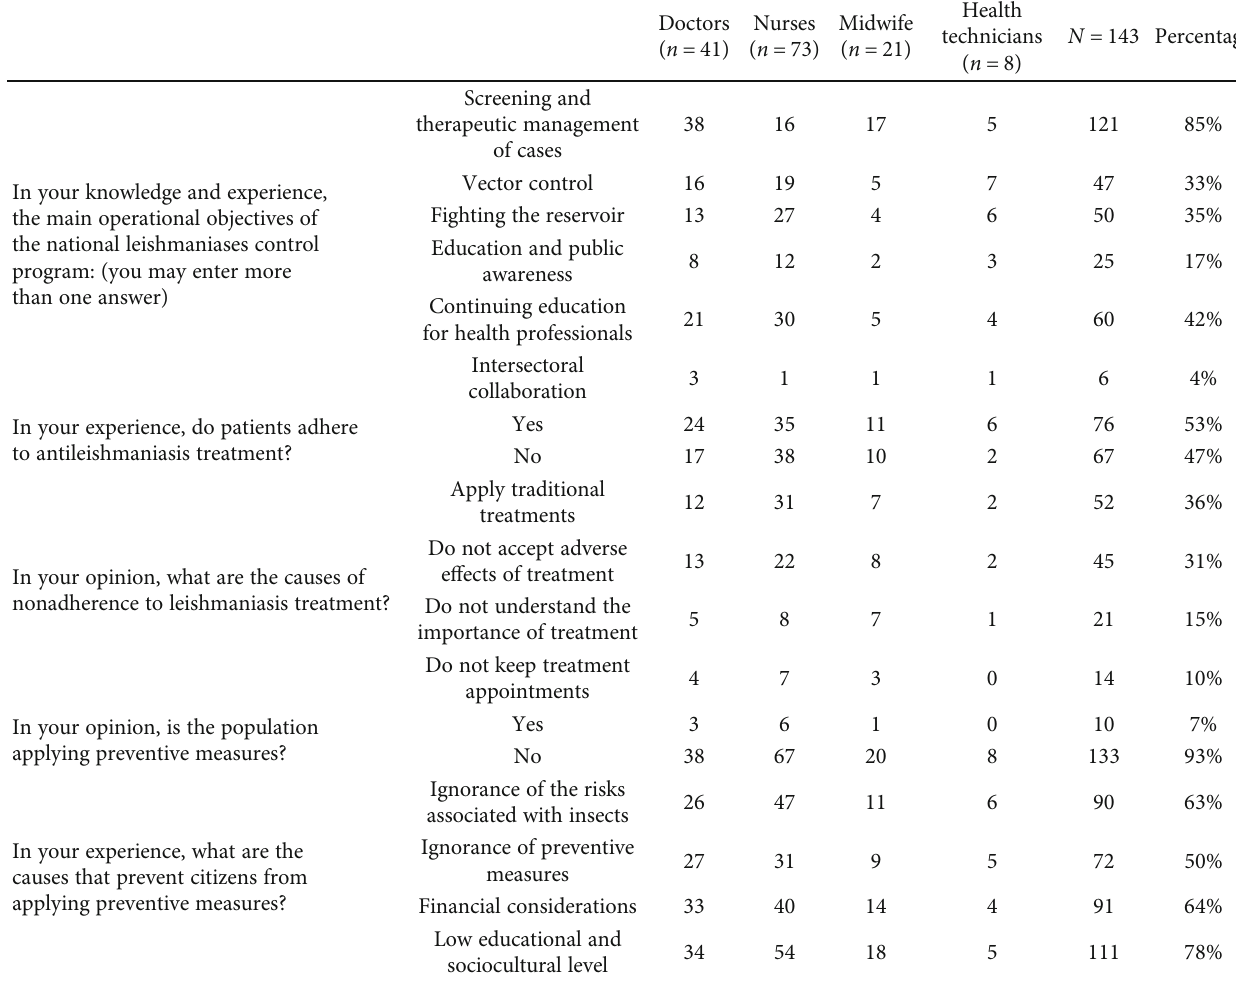
Table 4: Knowledge and experiences of health professionals in the operationalization of the program ’ s